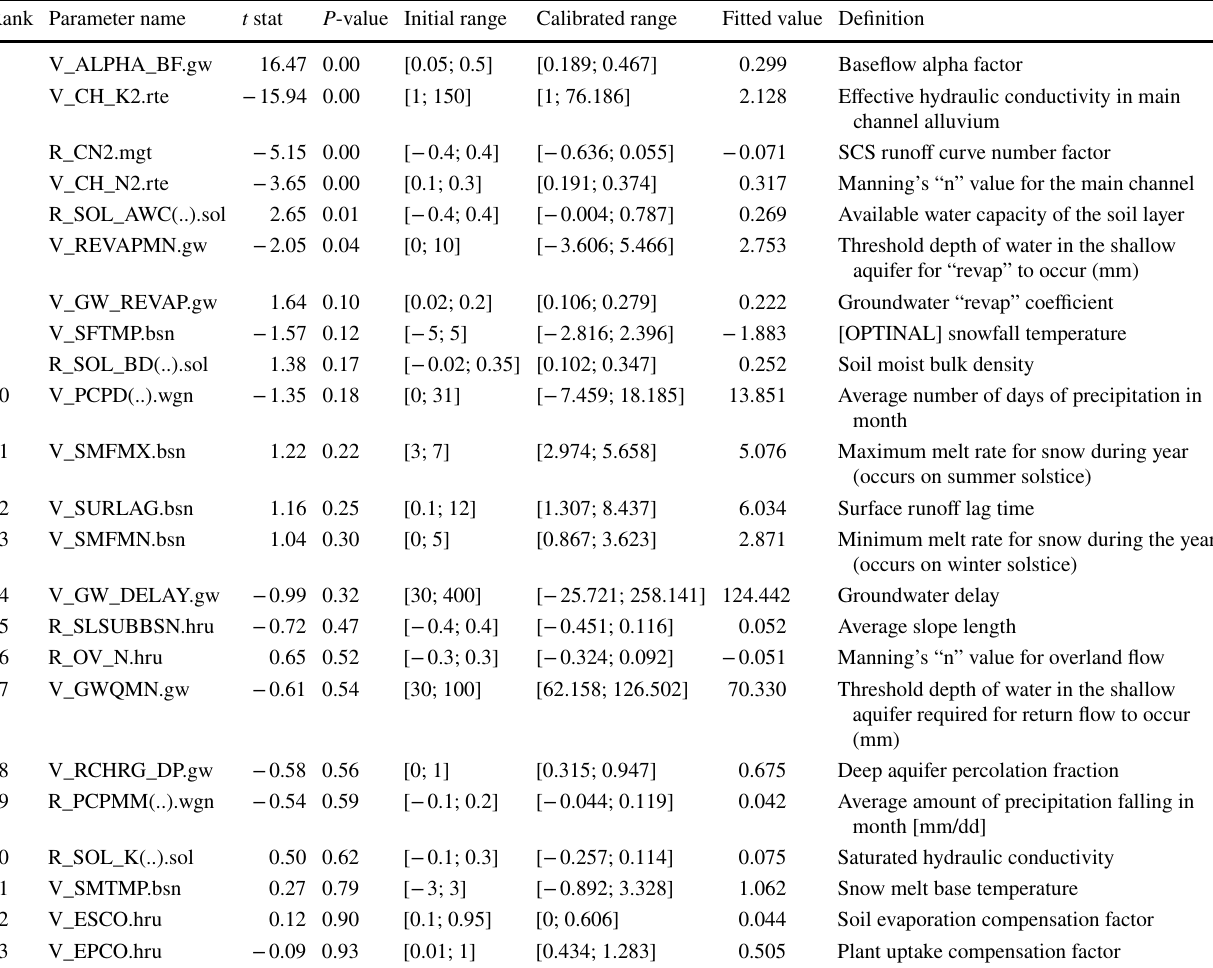
Table 4 Sensitivity rank and uncertainties range of the model parameters based on SUFI2 algorithm for runoff calibration on monthly basis